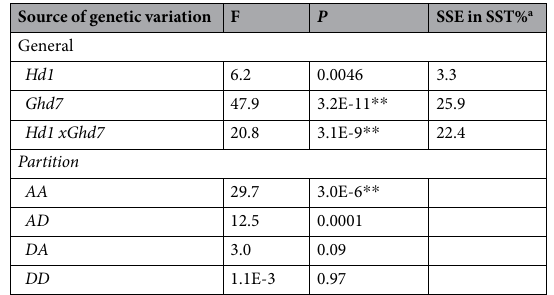
Table 2. Two-way ANOVA in the F2 population from the cross between ZS-hd1 and ZS-Ghd7. a Percent of effect sum of squares in the total sum of